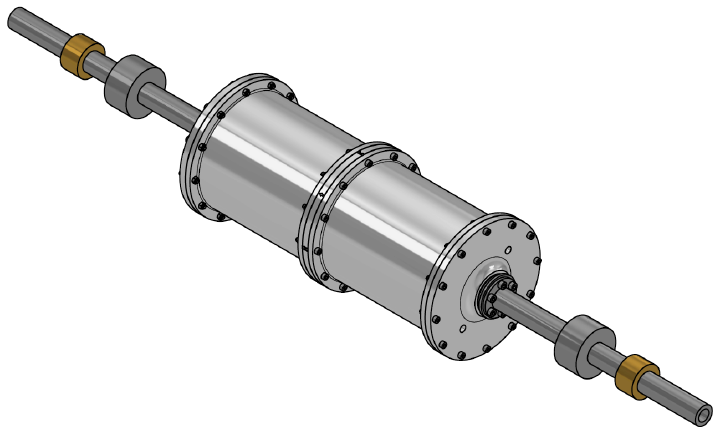
Figure 16. 3D model of the rotor prototype under